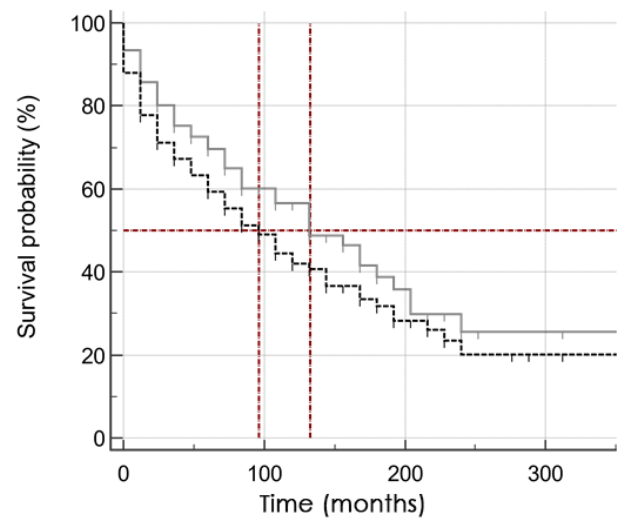
Figure A2. Kaplan–Meier survival curve in subgroups of patients Lp(a) < 30 mg/dL (grey solid line) and Lp(a) ≥ 30 mg/dL (black dotted line). 50% of patients in the group with elevated Lp(a) concen ‐ tration lived to MACE after 96 (95% CI 60–144) months vs. 132 months (95% CI 84–192).